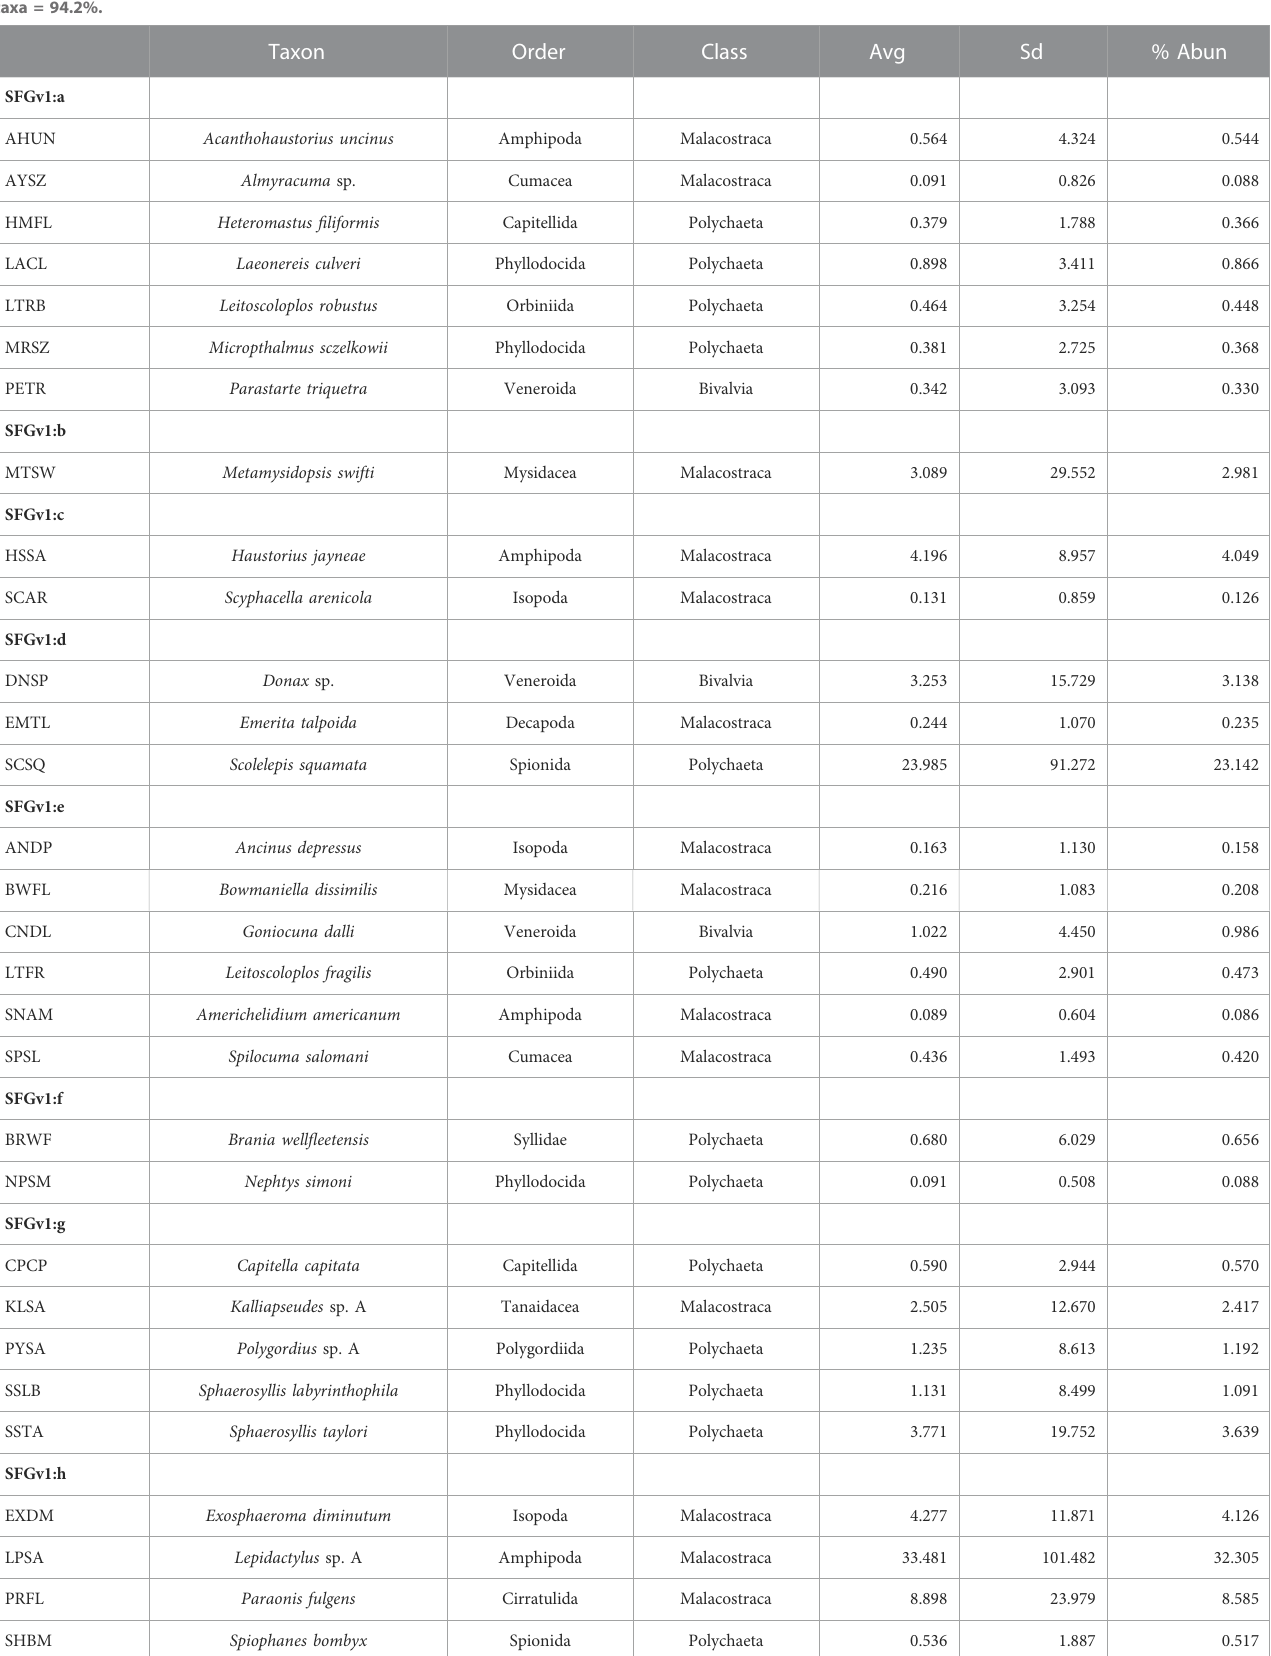
TABLE 1 Eight coherent SFGv indicator groups designated by Type 3 SIMPROF tests from among the 30 ‘ most important ’ taxa as selected by PRIMER-e. SFGv indicator groupsexemplifyco-occurringtaxa.(Avg – averageabundance; SD – standarddeviation;%Abun – percent oftotalabundance; cumulativeabundanceforthe30selected taxa =